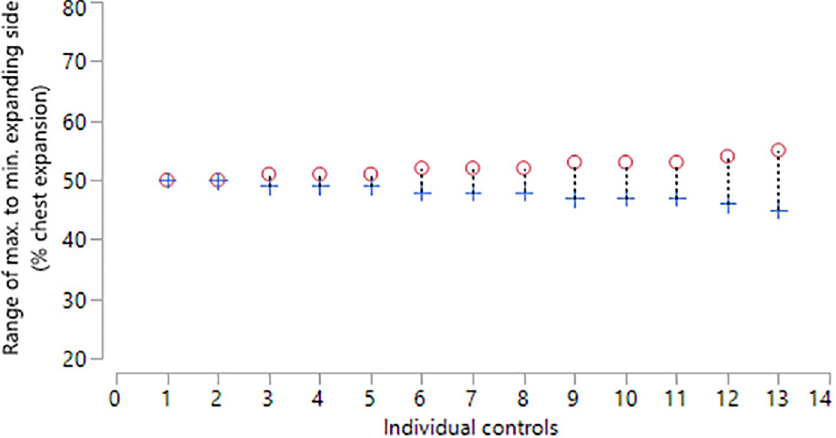
Fig 4. Percentage right and left thoraco-abdominal (TA) contributions for healthy controls (n = 13) during one minute of tidal breathing. Circle = maximal expanding side, Cross = minimal expanding